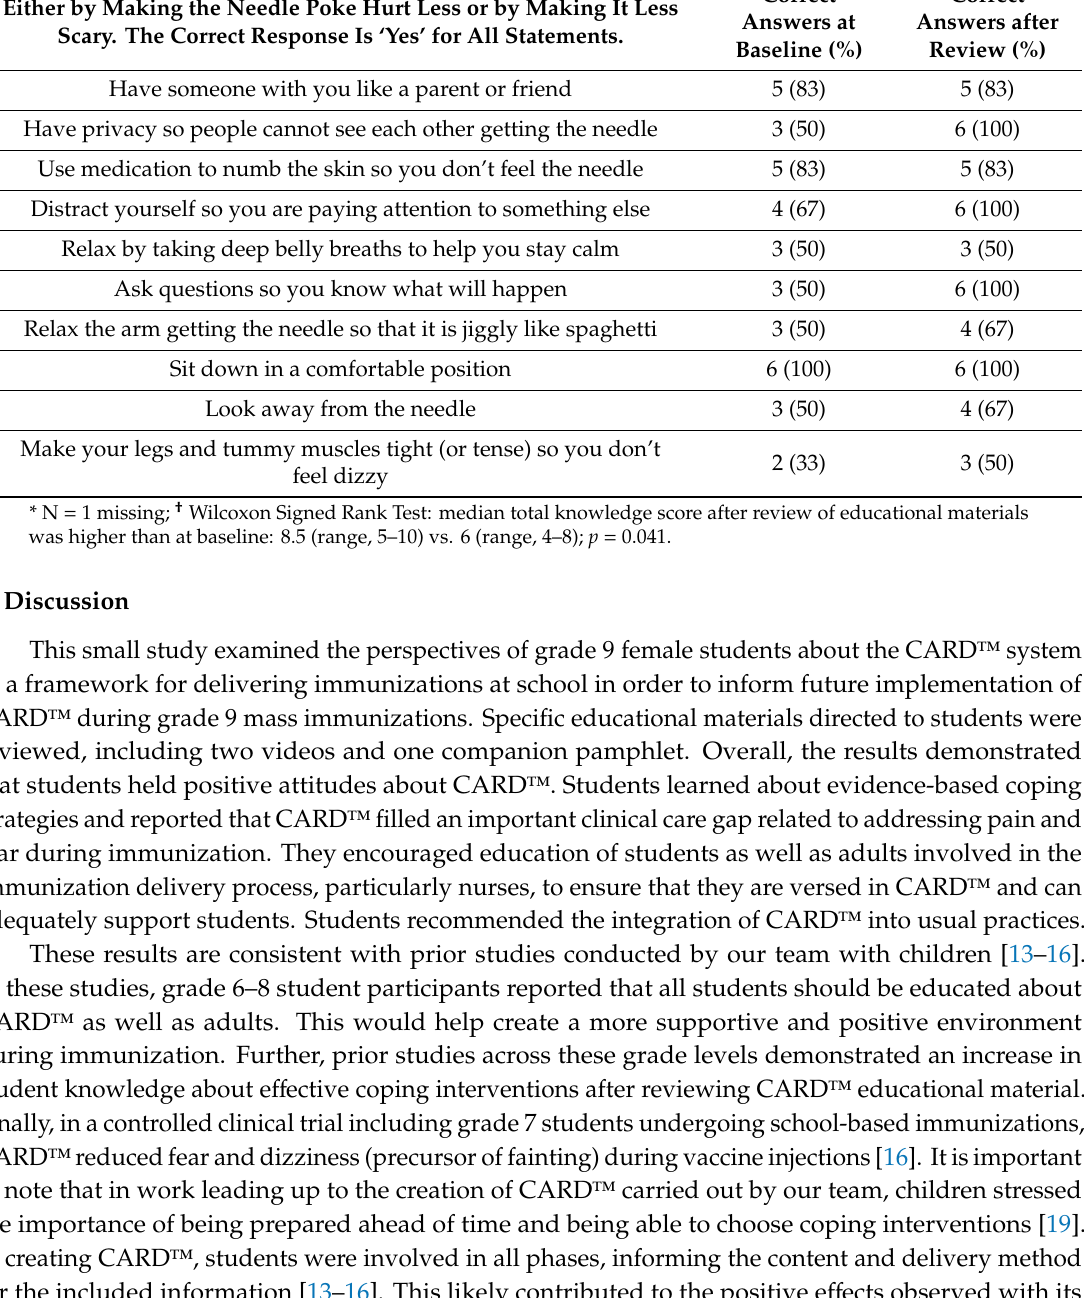
Table 3. Student knowledge scores before and after review of educational materials ( n = 6) * † . Strategies That Can Help to Make Needles More Comfortable, Either by Making the Needle Poke Hurt Less or by Making It Less Scary. The Correct Response Is ‘Yes’ for All Statements.